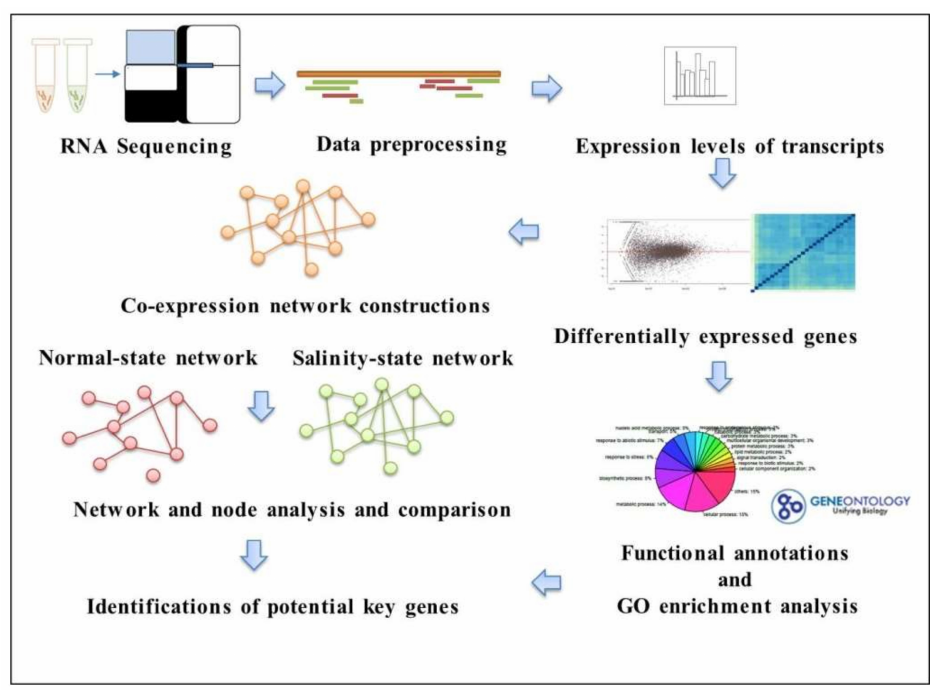
Figure 1. The analysis workflow to identify key genes with different state networks. Table 2. Number of differentially expressed genes under salt stress for the seedling and booting stages.